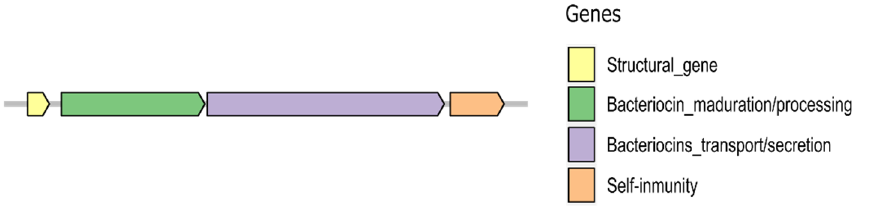
Figure 1. Common bacteriocin gene cluster organization. The general genetic organization for bacteriocin production involves four main types of genes: structural genes; genes involved in maturation, processing; genes involved in the transport, secretion of bacteriocin; and genes that confer self-immunity to the bacteriocin.